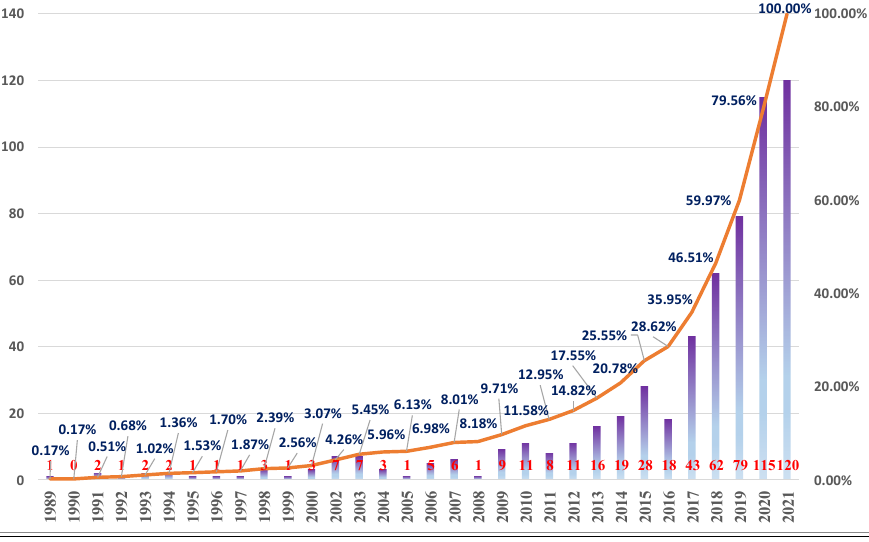
Figure 10. Annual number of articles published.